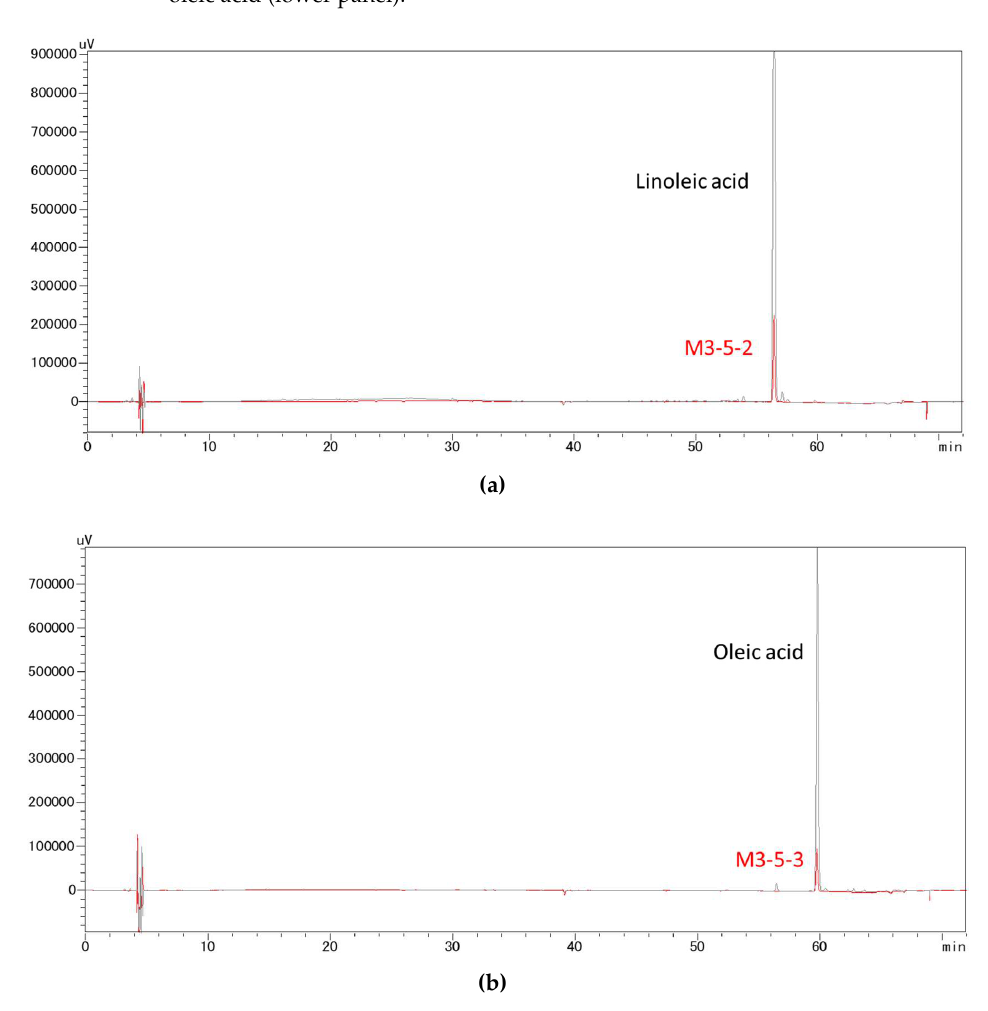
Figure 4. HPLC chromatogram of the bioactive fractions against pancreatic lipase in vitro. ( a ) Fraction M3-5-2 and the linoleic acid standard. ( b ) Fraction M3-5-3 and the oleic acid